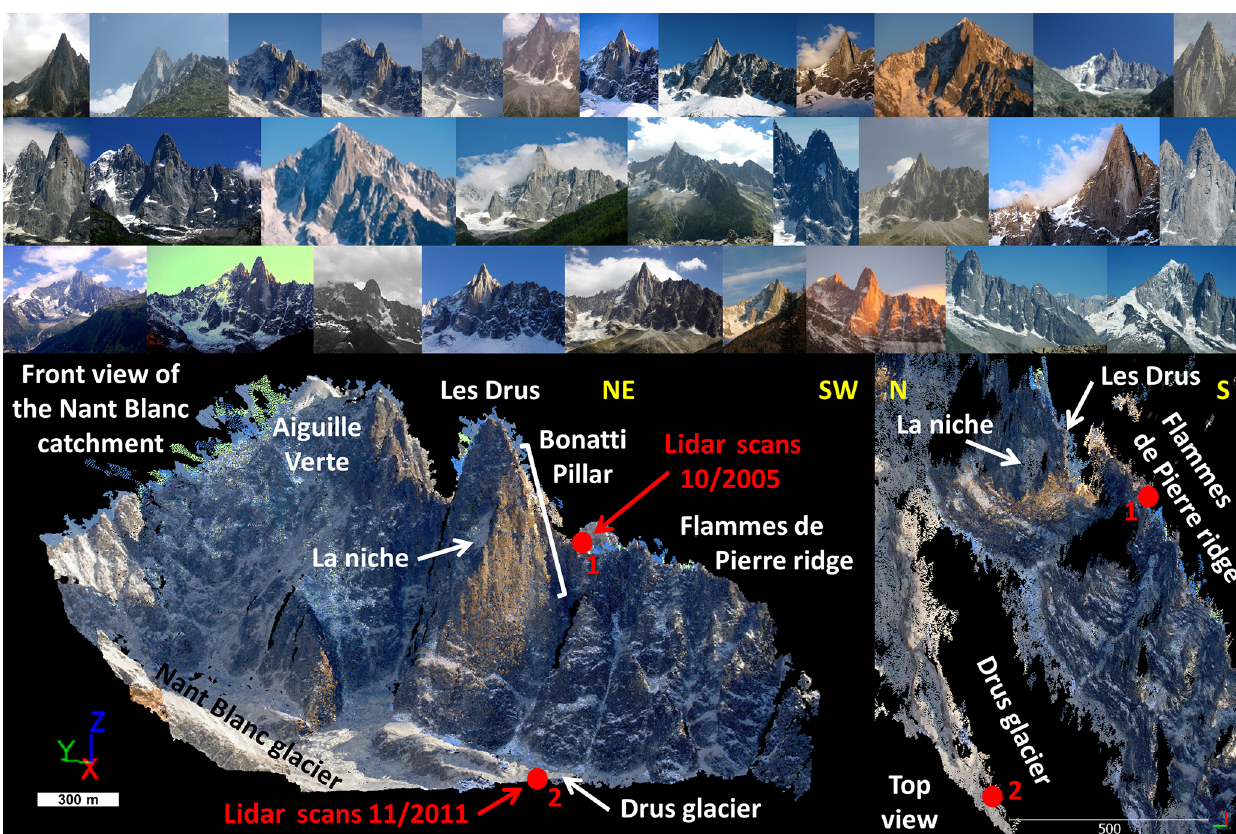
Figure 2. Catalogue of the 30 pictures selected on the Internet (upper part; photo credits, citations and links available in Appendix A) and used to reconstruct the northwestern side (the Nant Blanc catchment) of the Aiguille Verte and Drus (lower part, front view and top view of the SfM point cloud) before the Bonatti Pillar collapse in June 2005. Both red dots show the location of the 2005 and 2011 ground-based lidar